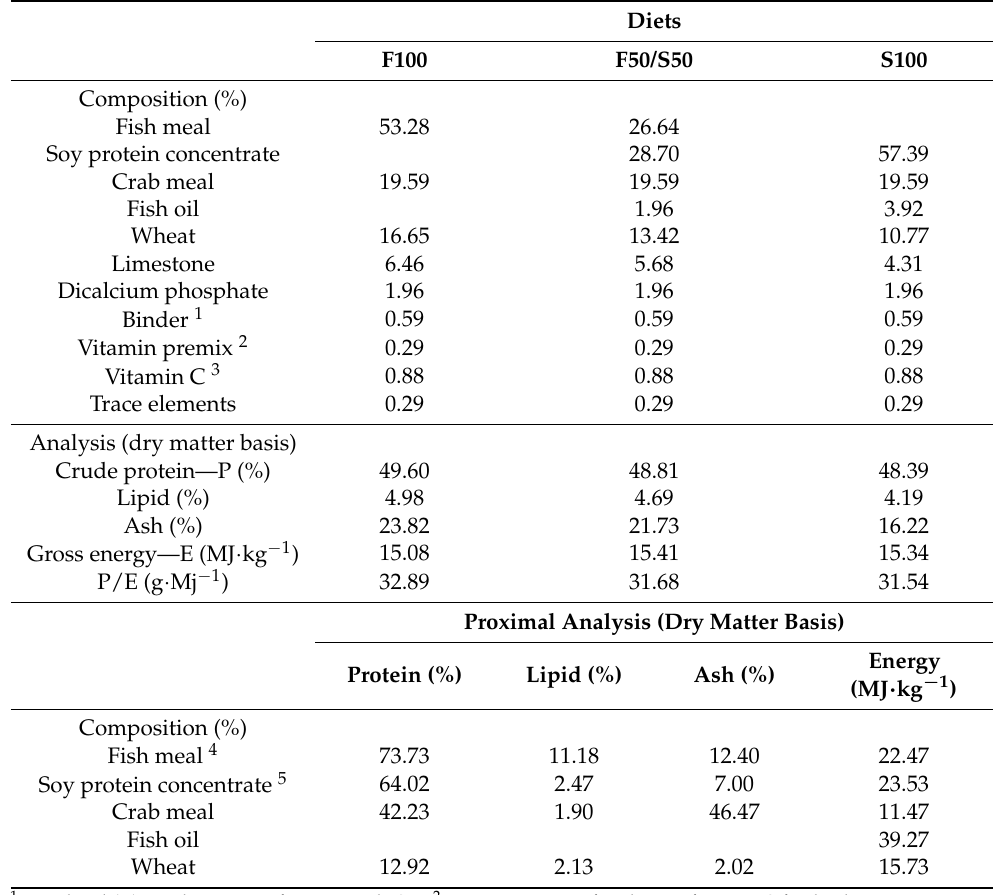
Table 1. Proximal composition of ingredients and three experimental